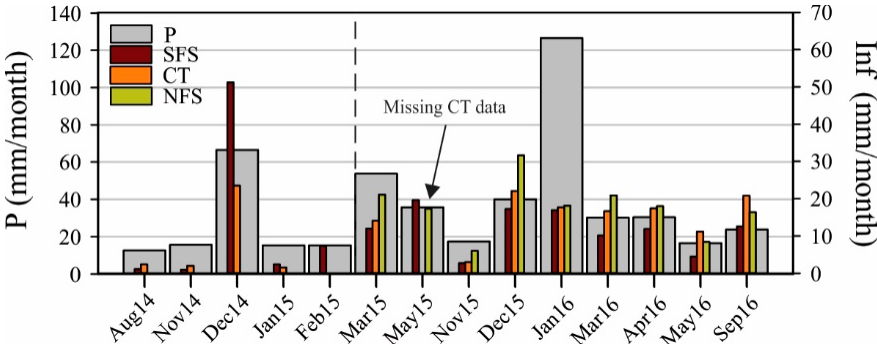
Figure 8. Monthly precipitation at CT weather station and monthly infiltration at SFS, CT and NFS. The vertical discontinuous line represents the beginning of the comparative period of the three monitoring sites.